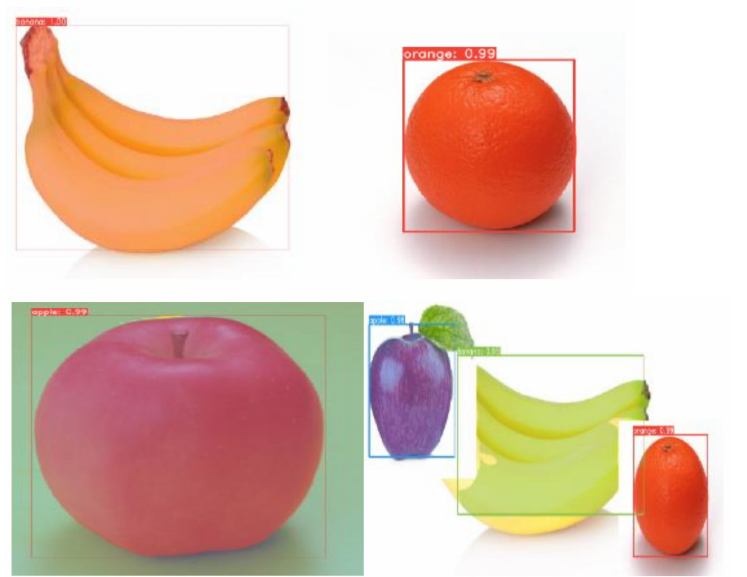
Figure 6. Detection results of multi-class targets. For the mixed multi-class target instance, it can be segmented well, and the segmentation effect of the algorithm can be significantly improved without increasing the amount of